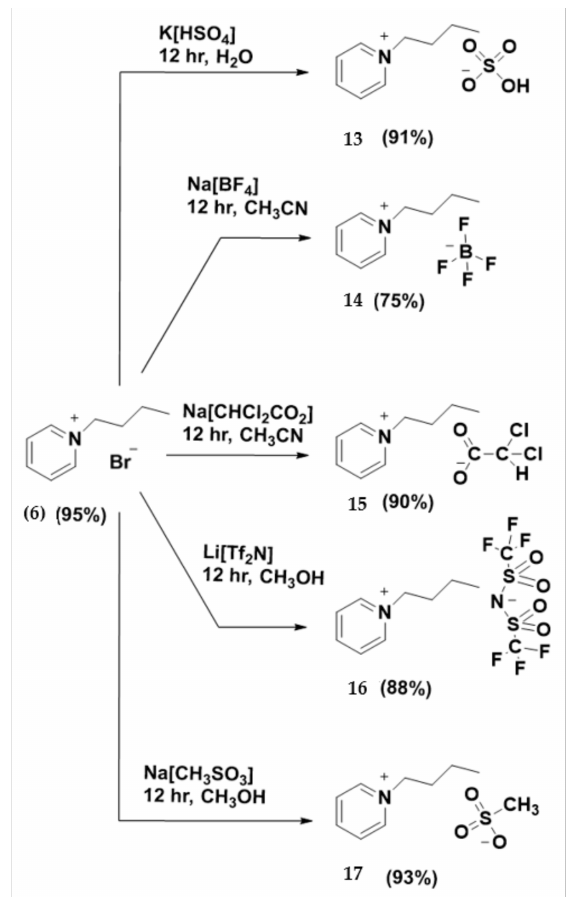
Scheme 3. Synthesis of butyl pyridinium-based ionic